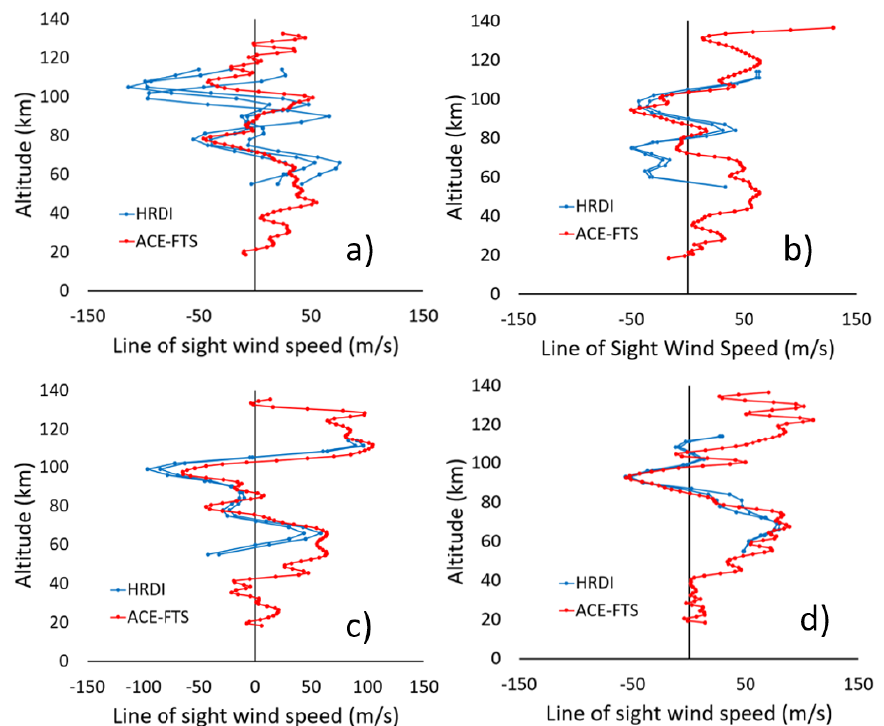
Figure 3. Comparison between ACE-FTS winds (in red) and selected HRDI results (in blue) for cases where multiple HRDI measurements were coincident with a single ACE-FTS occultation. ( a ) ss3475 (where ss stands for sunset), measured 4 April 2004; ( b ) ss3486, measured 5 April 2004; ( c ) ss5302, measured 5 August 2004; and ( d ) ss5341, measured 9 August 2004.